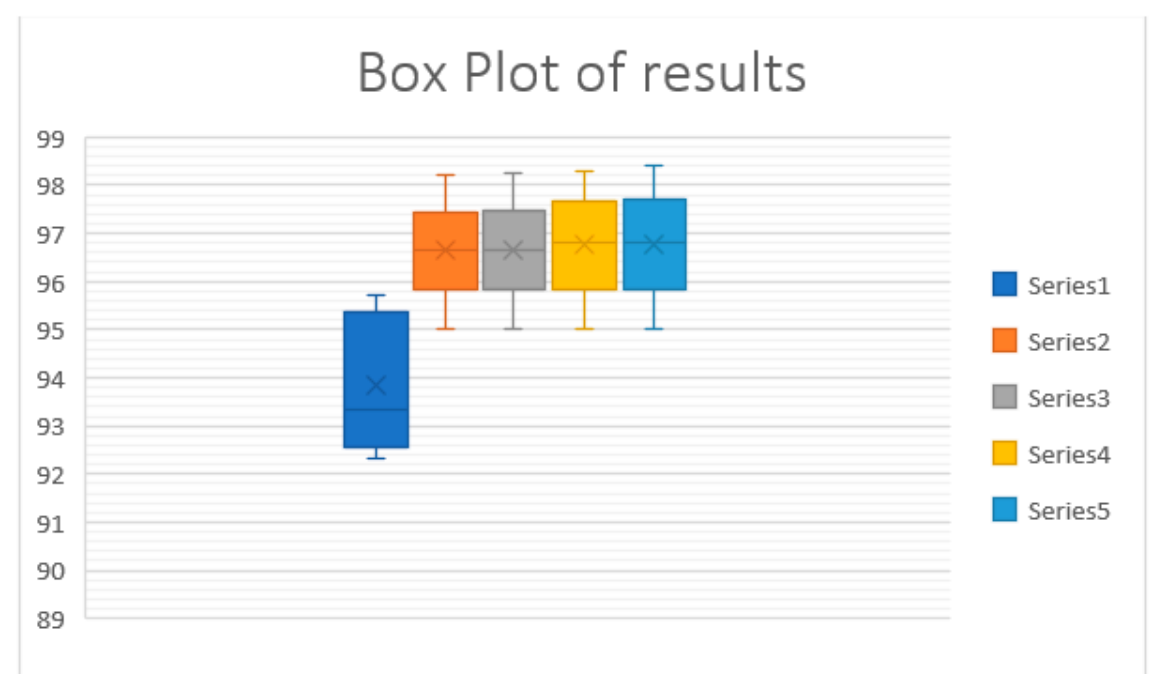
Figure 7. Box plot of results, Series1, Series2, Series3, Series4, and Series5 represents results for epochs 20, epochs 30, epochs 40, epochs 50, and epochs 60,